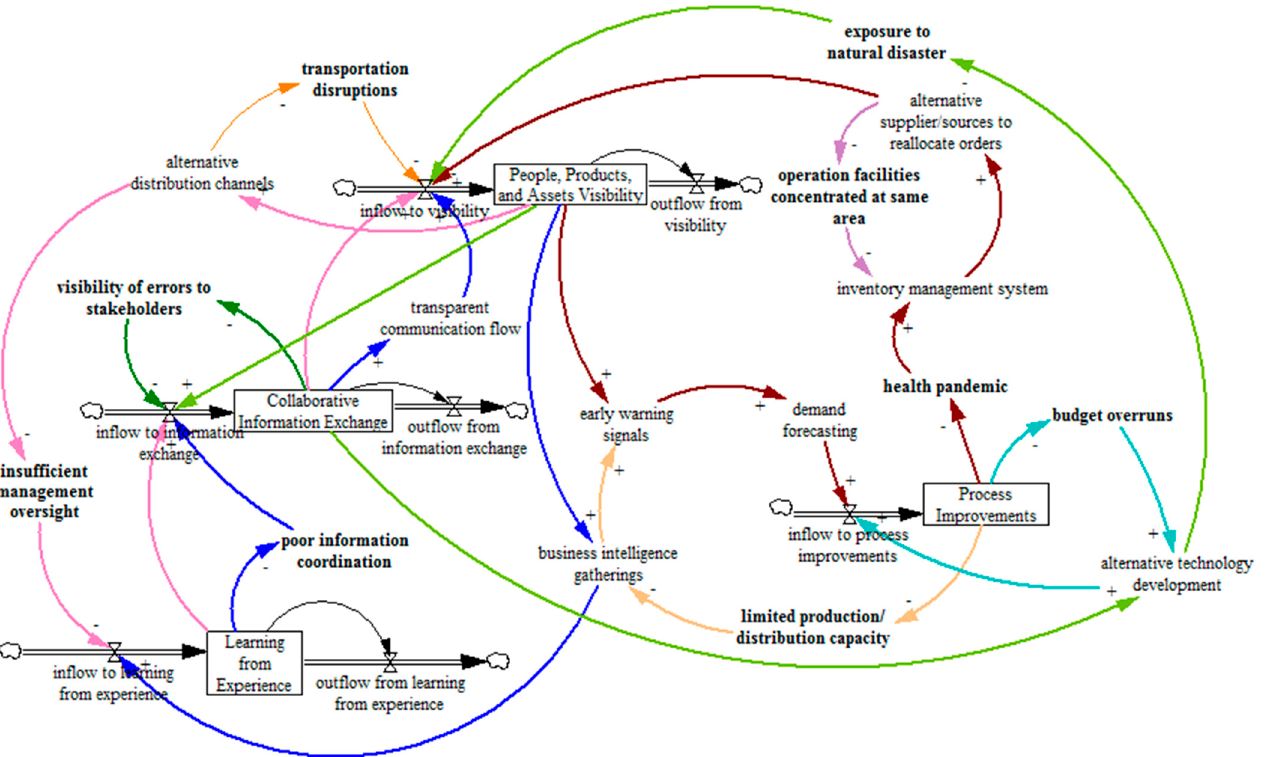
Figure 13. System dynamics model.